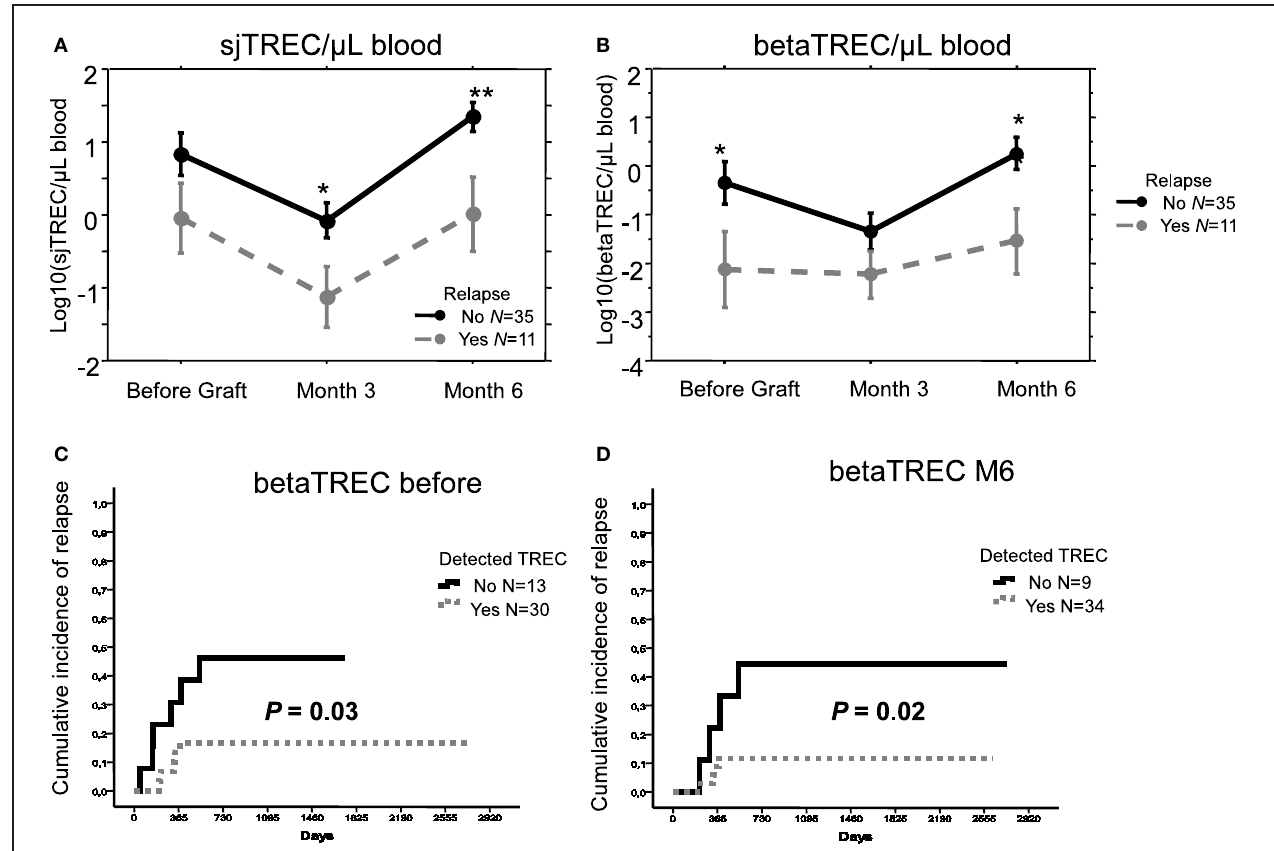
only (Haplo). Patients who experienced relapse were represented with gray dotted lines, while patients maintaining complete remission with black plain lines. ∗ p < 0 . 05, ∗∗ p < 0 . 01. Cumulative incidence of relapse in patients affected by malignant disorders who did or did not have detectable betaTREC before (C) , and at month 6 after graft (D) ( p in Log Rank